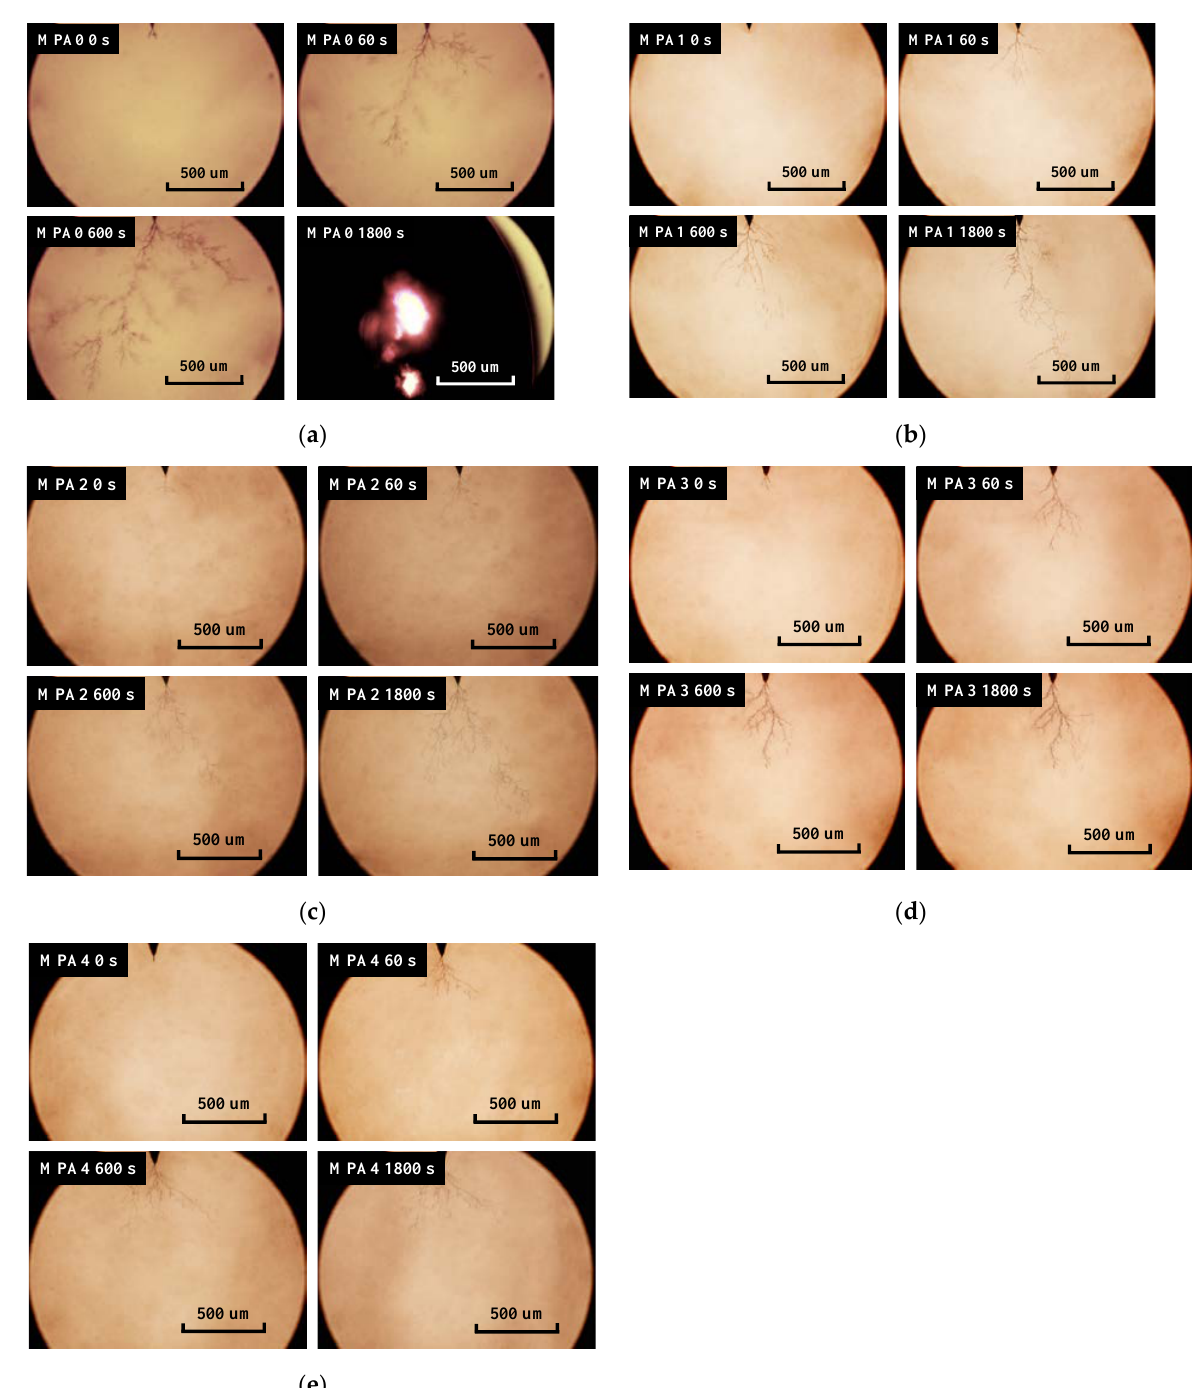
Figure 5. Propagation of each ratio of the electrical tree at 18 kV. ( a ) MPA0, ( b ) MPA1, ( c ) MPA2, ( d ) MPA3, ( e ) MPA4.